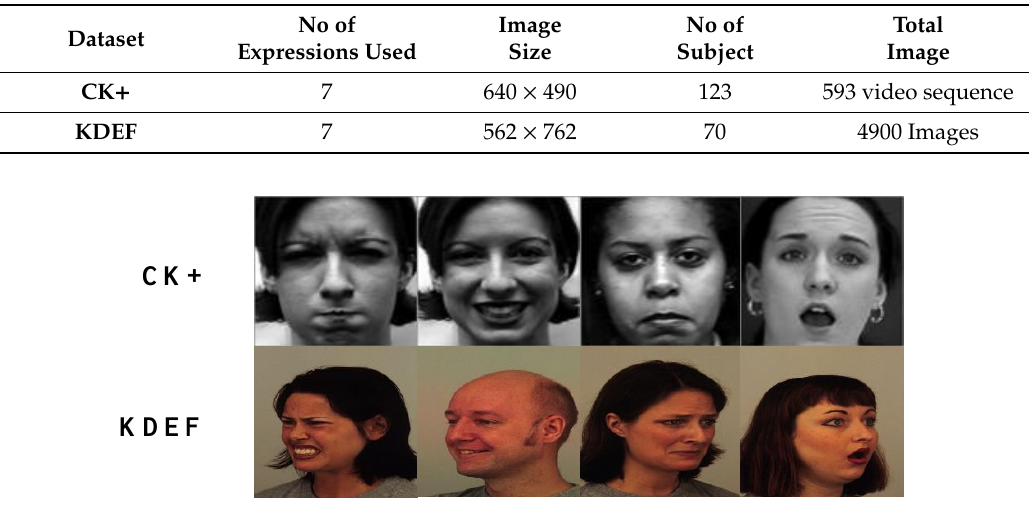
Figure 1. Sample face image from Extended Cohn–Kanade (CK + ) and Karolinska Directed Emotional Faces (KDEF) datasets.